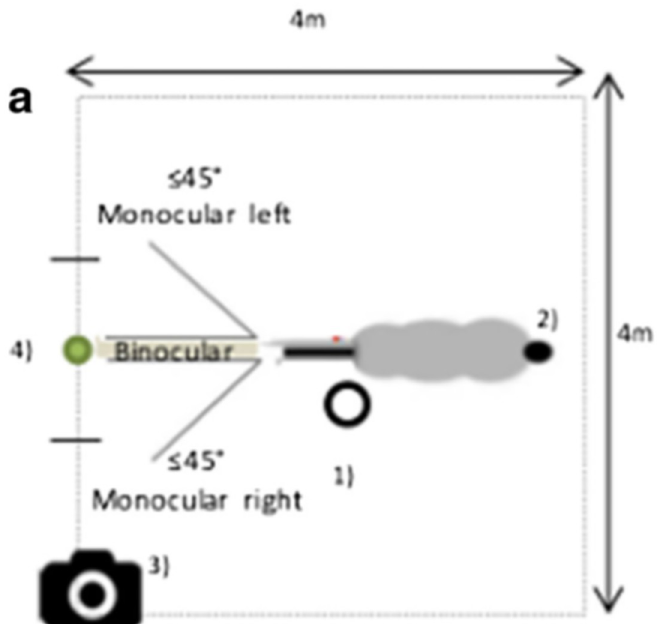
Fig 1. Diagram of the experimental setup of the visual attention test (VAT): Horses’ position in the stall during the VAT: 1 the experimenter, 2 the horse, 3 the camera; and 4 the stall door where the visual stimulus was projected. Binocular gaze: the horse faced the visual stimulus with head ( i . e . mid line of the head) and both eyes oriented towards it. Monocular gaze: the horse faced the head at less than 45˚ to the right or to the left towards the visual stimulus. Angles were evaluated with respect to the stall horizontal plan and to the mid stall door wall where the stimulus was projected.